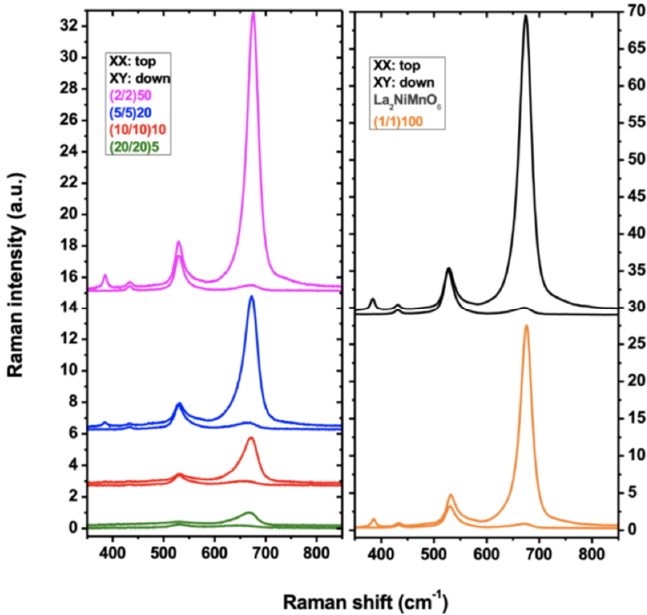
Figure 6. Polarized Raman spectra of nLNO/nLMO (n/n) SLs (20/20, olive), (10/10, red), (5/5, blue), (2/2, magenta), (1/1, orange), and of the LNMO film (black), measured in XX and XY polarization configurations. Adopted with permission from American Physical Society (Copyright 2021) ref. [9].